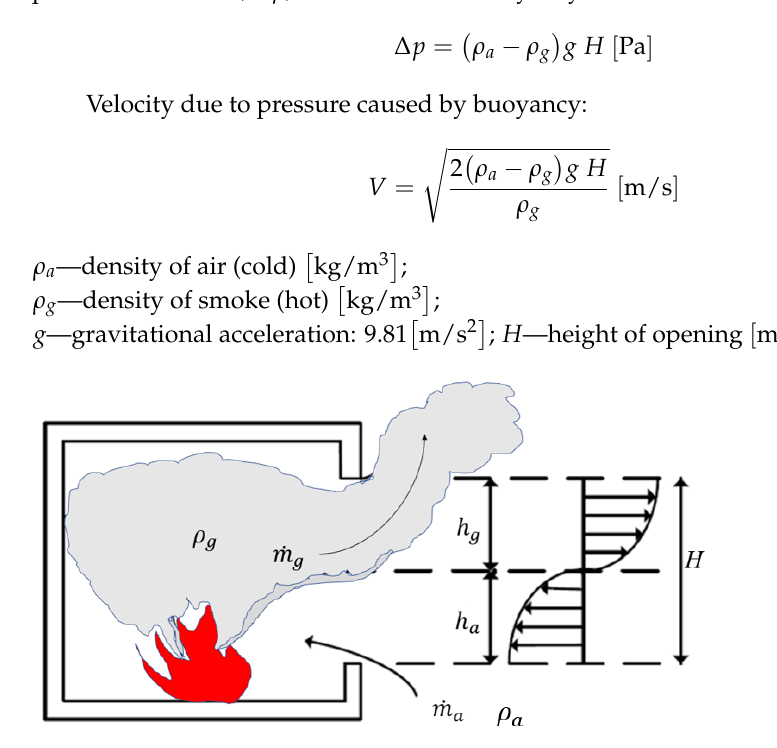
Figure 3. Buoyant flow across the vent of an enclosure fire.